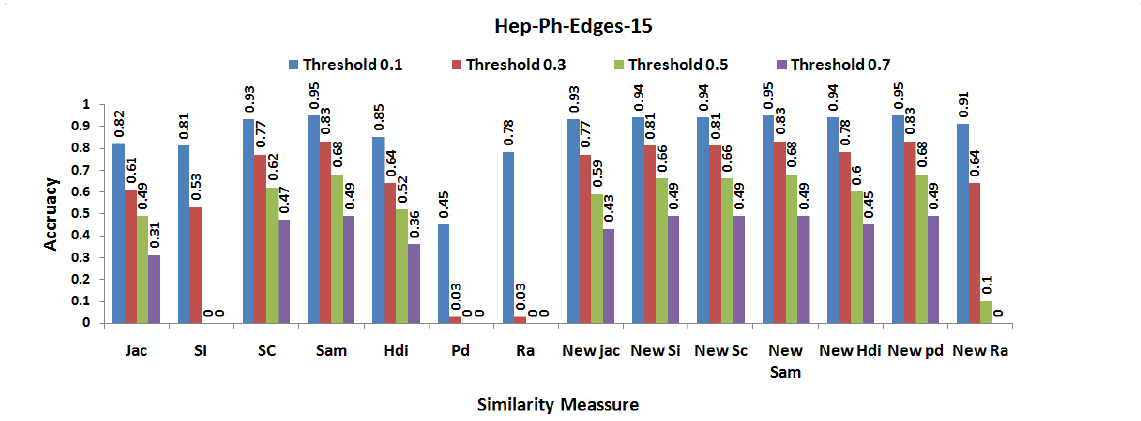
Figure 10. Prediction Results using HepPh Dataset with 15%